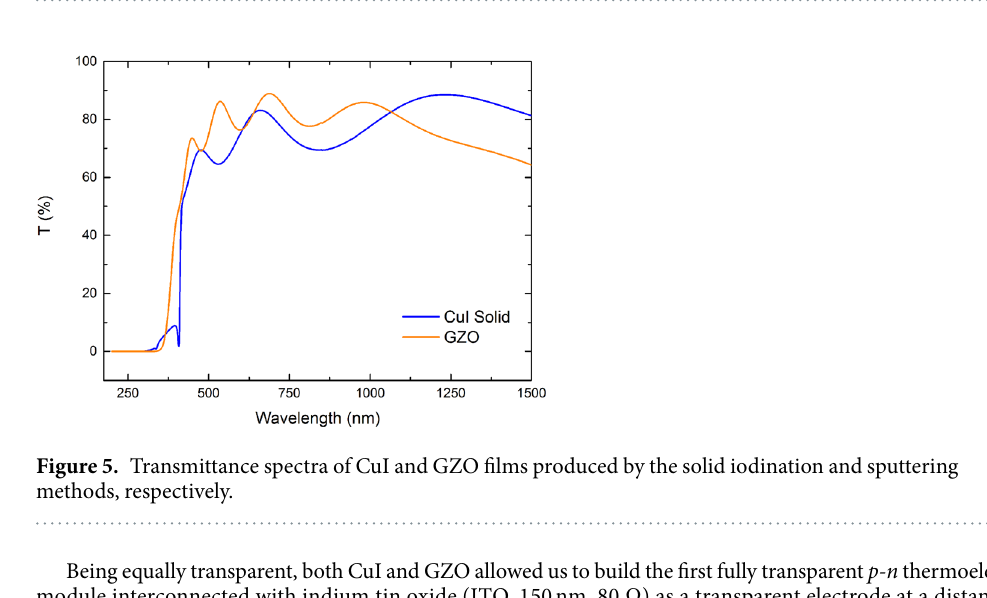
Figure 4. ( a ) and ( c ) a comparison of specular transmittance and total reflectance spectra of CuI films prepared by three methods: vapour (302 nm thick); t. evaporated (50 nm thick); solid (287 nm thick), with an inset ( b ) corresponding to a zoom-in at 300 to 450 nm range. ( b ) the derivative of absorption coefficient to determine the optical band gap and ( d ) absorption coefficient for the band gap energies.